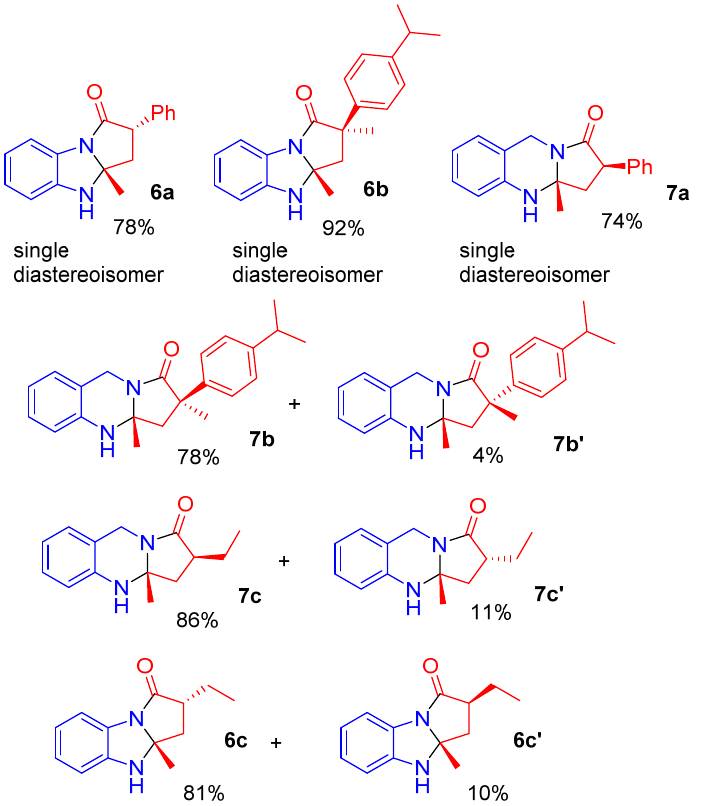
Figure 2. Diastereoselectivity observed in the cascade reactions with phenylenediamines or o -aminobenzylamines reported by Patil and col.